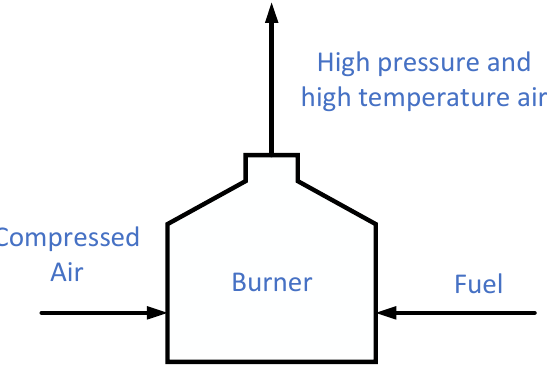
Figure 5. Structure diagram of combustor.